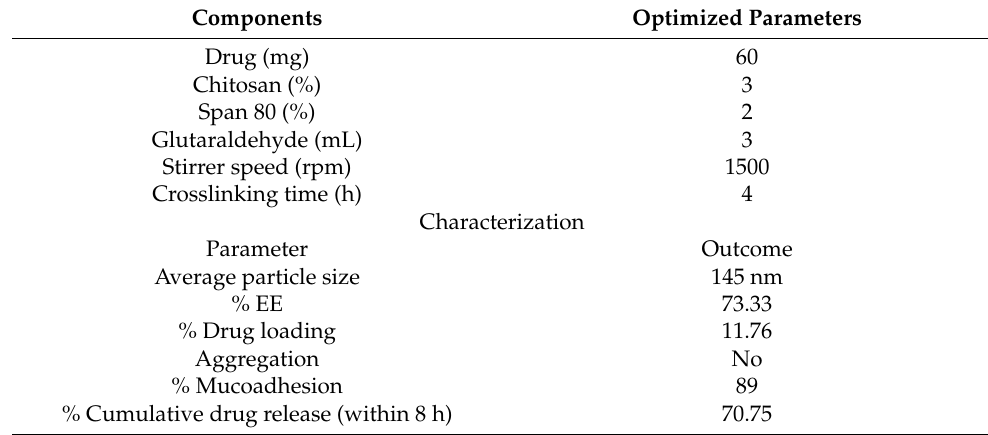
Batches Drug: Polymer Table 5. Optimized formulation parameters for the development of rivastigmine nanoparticles (D8) and characterization